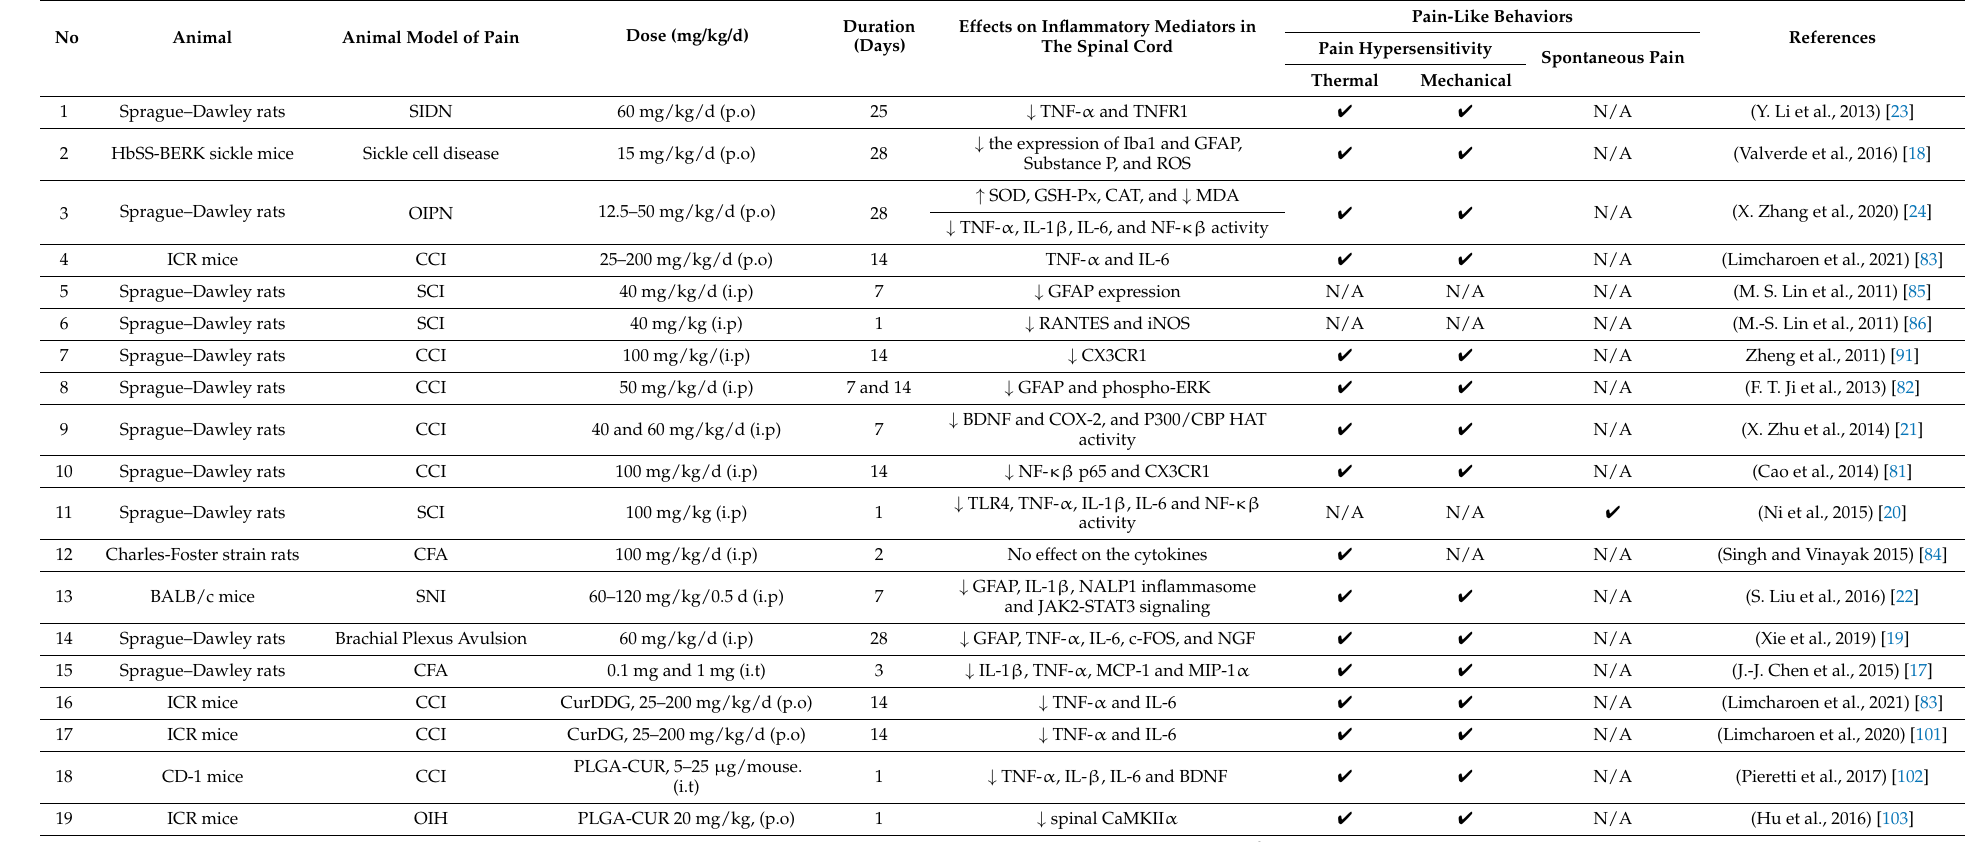
Table 3. Overview of the effect of curcumin on neuroinflammation-mediated chronic pain in animal